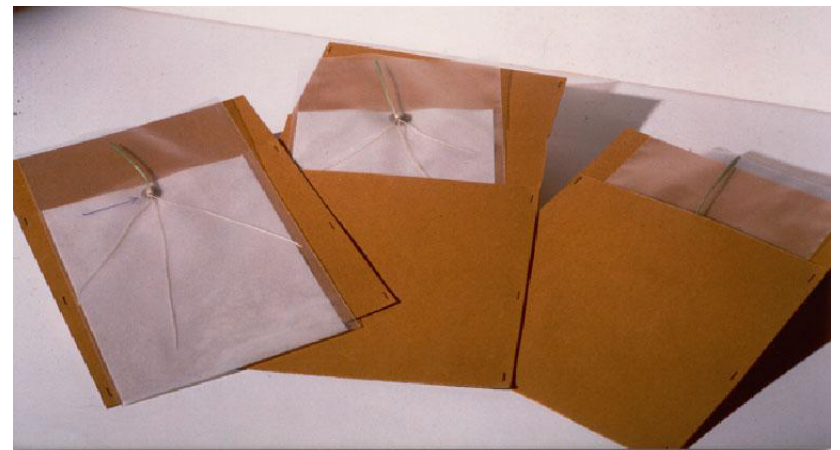
FIGURE 4 . Wheat growth model; seed attached to filter paper by a piece of clay, then placed in a transparent cellophane envelope and inserted in a larger cardboard